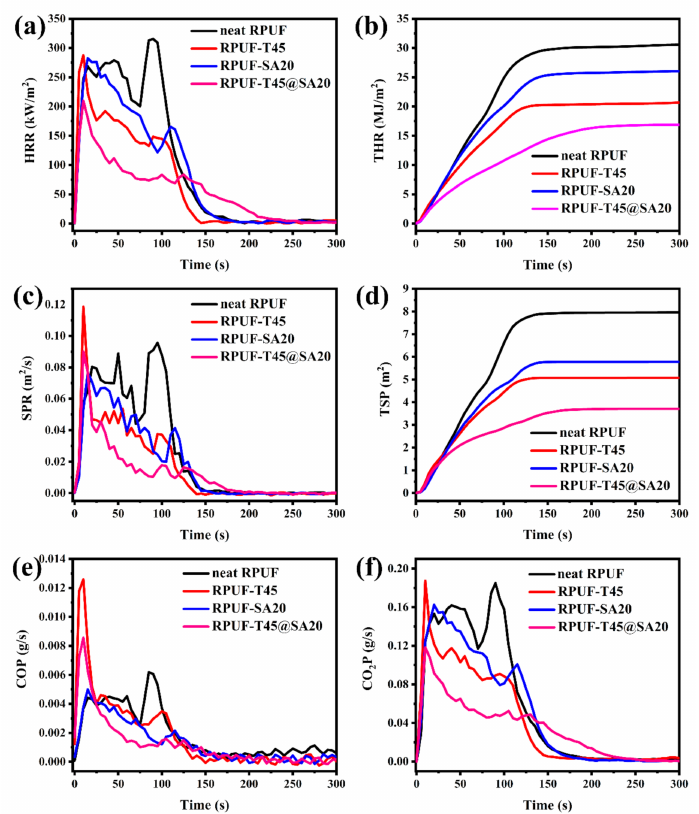
Figure 10. HRR curves ( a ), THR curves ( b ), SPR curves ( c ), TSP curves ( d ), COP curves ( e ) and CO 2 P curves ( f ) of neat RPUF, RPUF–T45, RPUF–SA20 and